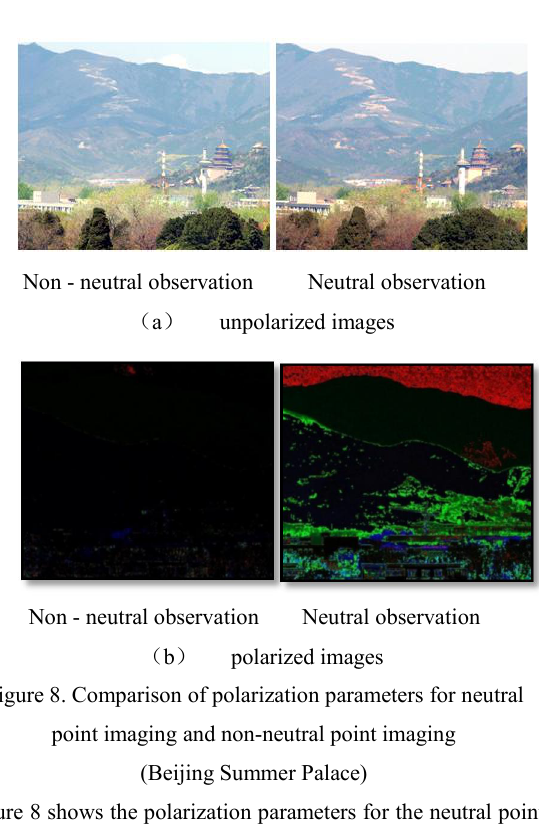
Figure 7. Geometric schematic diagram of ground experiment validation